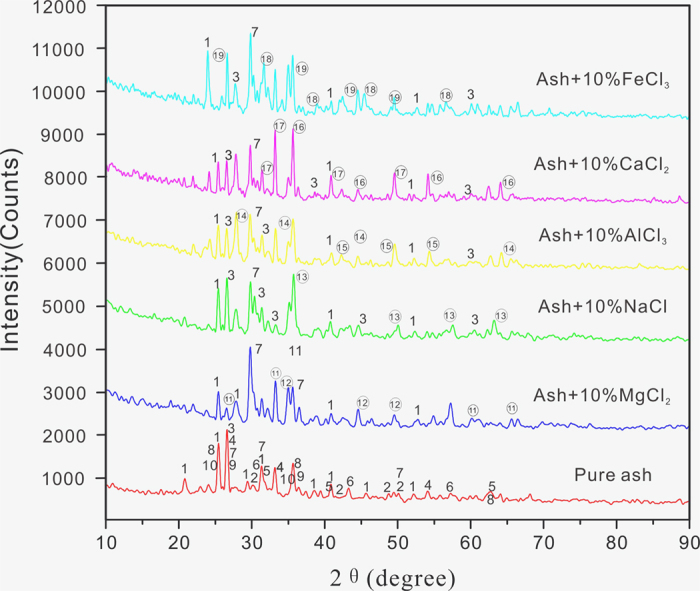
XRD of MSS fly ash before and after calcination with the addition of chlorinating agents.1. CaSO4; 2. CaCO3; 3.NaCl; 4. KCl; 5. Ca2Al2SiO7; 6. Ca2(PO4)3; 7. CaO; 8. SiO2; 9. CaAl2SiO6; 10. CaClOH; ⑪. CaAl2Si2O8; ⑫. Ca3Mg(SiO4)2; ⑬. NaCa4Al3O9; ⑭. Ca3Al6Si2O16; ⑮Al2O3; ⑯NaCa4Al3O9; ⑰CaSiO3; ⑱Fe2O3; ⑲nFe2Al4Si5O18.